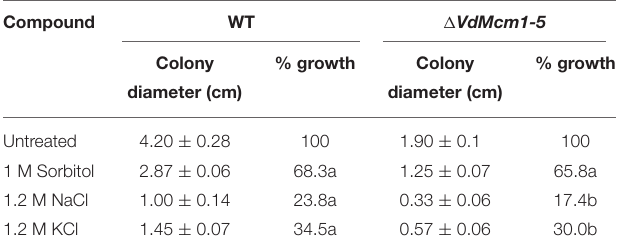
TABLE 1 | The radial growth of wild type and 1 VdMcm1-5 mutant in response to osmotic stresses with 1 M Sorbitol, 1.2 M NaCl, 1.2 M KCl. Compound WT 1 VdMcm1-5 Colony % growth Colony % growth diameter (cm) diameter (cm)